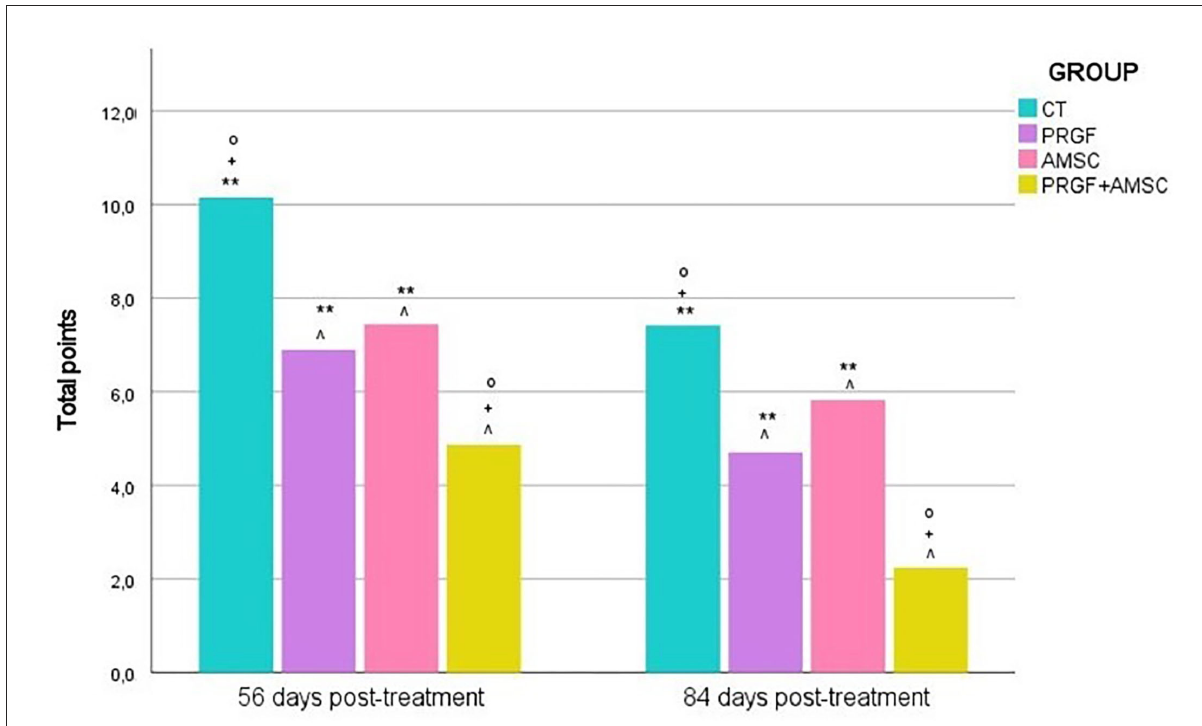
FIGURE6 Macroscopic assessment of the chondral defect 56 and 84 days after the intraosseous infiltration following the Goebel et al. scale. Total points received by each treatment group. Significantly higher scores are shown by CT group, followed by the AMSC and PRGF groups, without significant differences between them. PRGF + AMSCs group achieved a significantly lower score. ∧ , significant differences with CT group; ◦ , significant differences with PRGF group; + , significant differences with AMSCs group; **, significant differences with PRGF + AMSCs group.